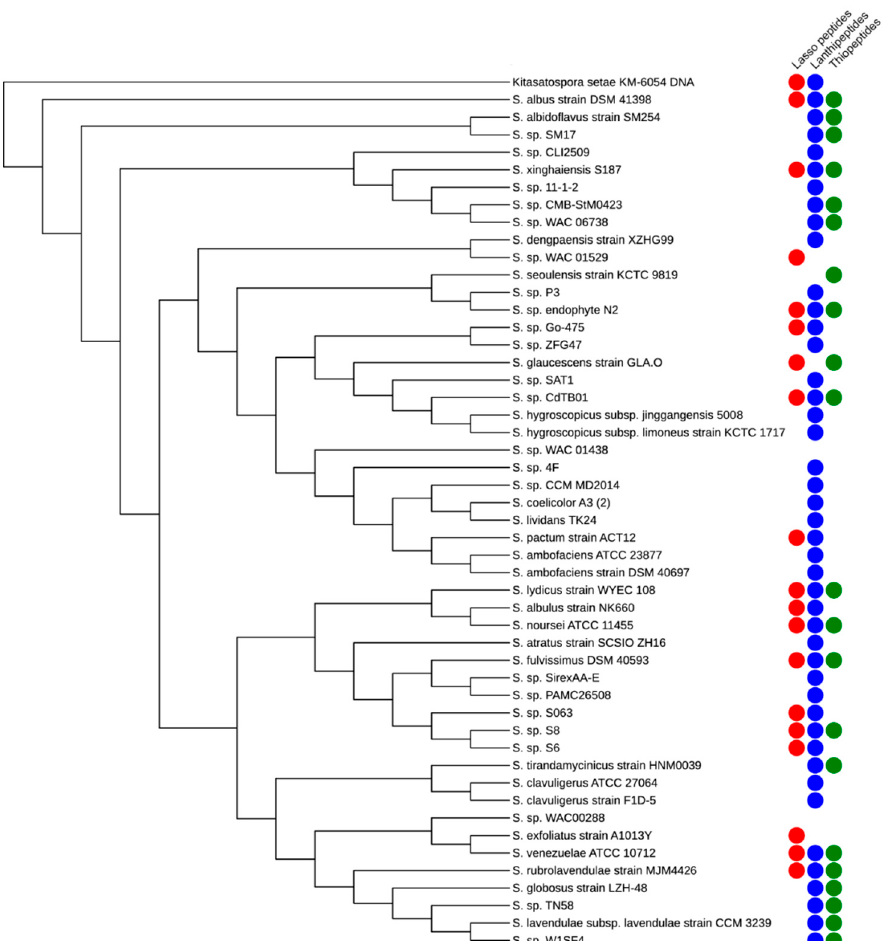
Figure 3. RiPP biosynthetic clusters in Streptomyces species. Cladogram was constructed using the sequences of six housekeeping genes ( atpD , recA , rpoB , gyrA , trpB , and 16S rRNA) from randomly-selected Streptomyces. Colored circles represent at least one RiPP biosynthetic gene cluster present in the genome. Red circles denote lasso peptide clusters; blue denotes lanthipeptides; green denotes thiopeptides.